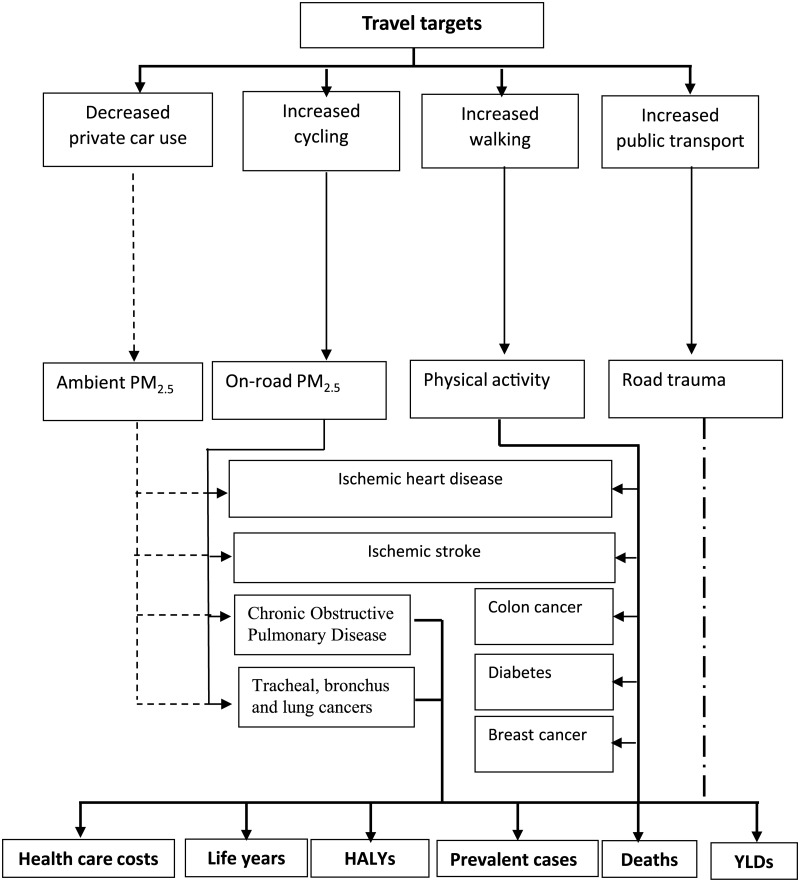
Analytical framework.Achieving the travel targets results in increased cycling, walking and use of public transport at the expense of private car travel (thick solid lines), which leads to gains in HALYs, gained life years, reduced health care costs, prevented/increased prevalent cases (diseases) and changes in death rates (thick lines at the bottom of the graph). Averted years lived with disability were estimated for road trauma. The effect of PA and PM2.5 were modelled via their impact on incidence of diseases (thin lines) and road trauma via its impacts on disability and mortality (captured by HALYs and YLDs) (interrupted thick lines). The effect of less private car use was quantified as improvements in ambient PM2.5, which benefits the population as a whole (interrupted thin lines).